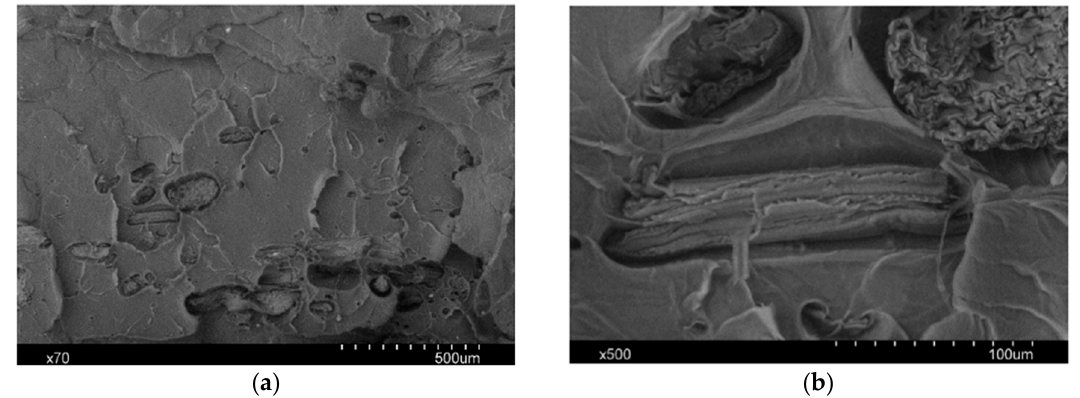
Figure 3 . PLA and 5 mm fiber interphase, SEM micrography, ( a ) ×70, ( b ) ×500. Figure 3. PLA and 5 mm fiber interphase, SEM micrography, ( a ) × 70, ( b ) × 500.